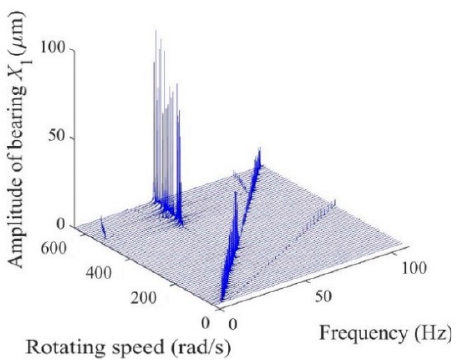
Figure 15. Frequency waterfall chart of the rotating shaft along a vertical direction at oil pressure of 0.75 MPa.